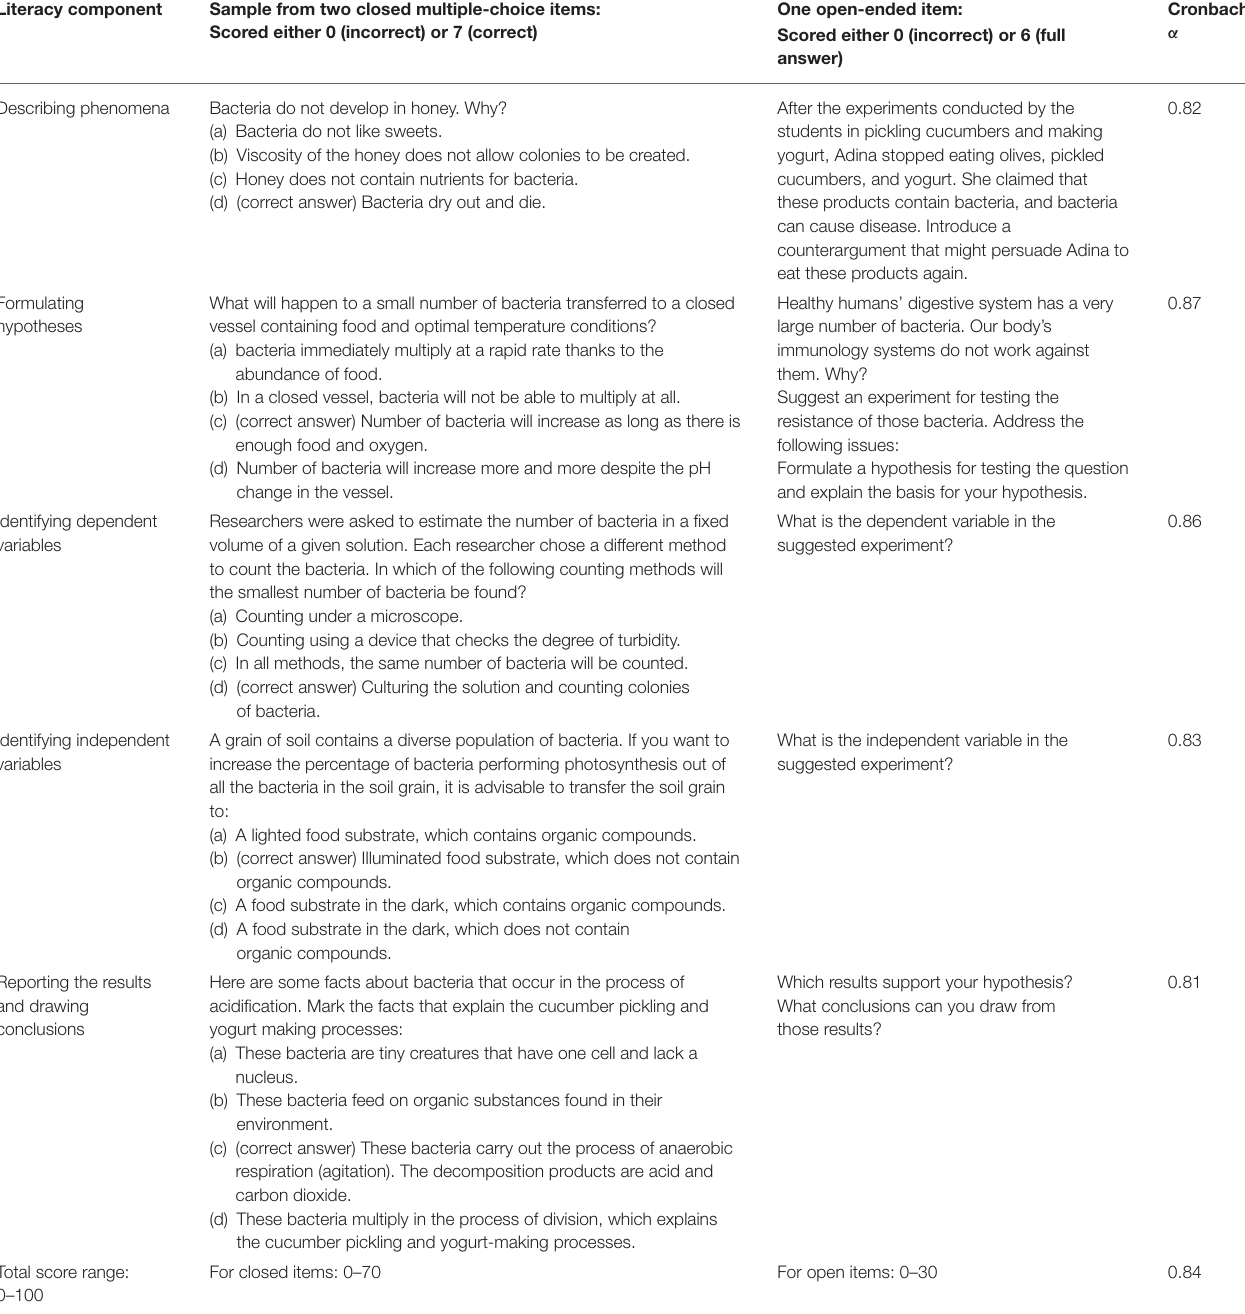
One open-ended item: Scored either 0 (incorrect) or 6 (full answer)